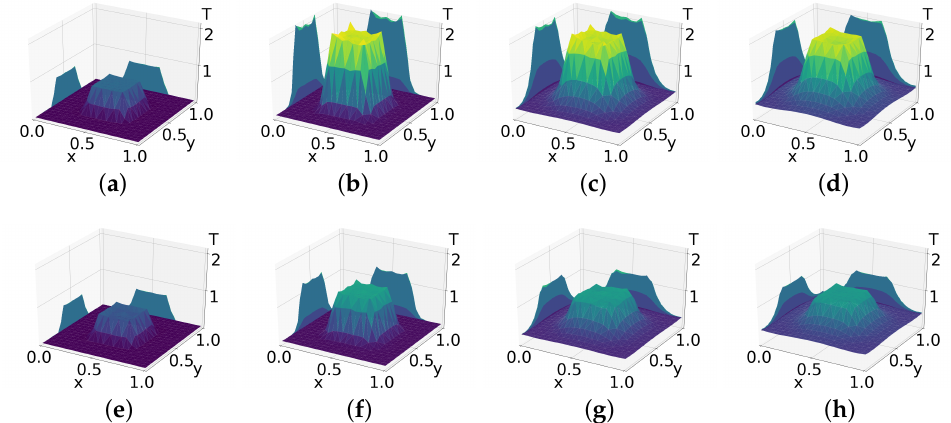
( t , x ) , ξ , t , x )] on the first prediction horizon by ( 0, H ]